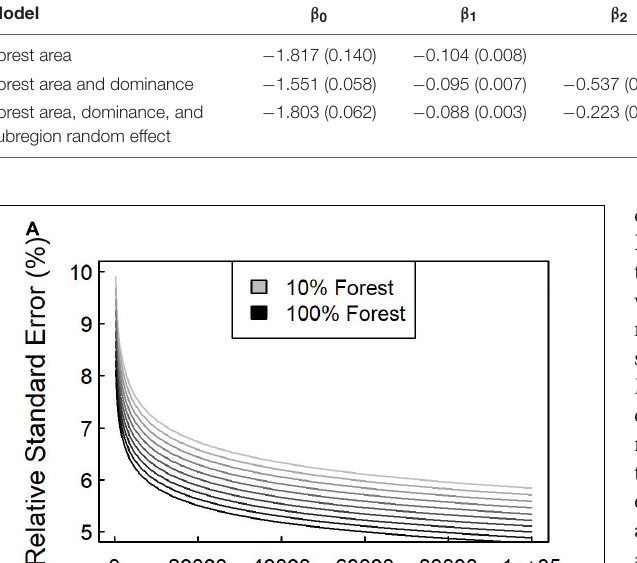
of fit, but R 2 -values were less than those reported for GREG ( Tables 1 , 2 ). This increased error in mean predictions was not reflected in the unadjusted SK variance estimates, which